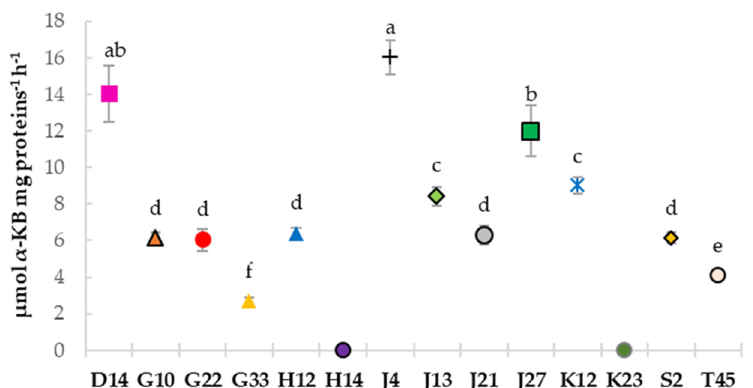
Figure 2. 1-aminocyclopropane-1-carboxylate (ACC) deaminase activity ( µ mol α -KB mg proteins − 1 h − 1 ) detected in the actinomycetes isolates. Results followed by different case letters are not signifi- cantly different according to Tukey’s post-hoc test ( p < 0.05) (n = 3). Table 3. Survival rate (%) recorded during the greenhouse experiment on T. durum for inoculated plant growth-promoting bacteria (PGPB) and uninoculated plants